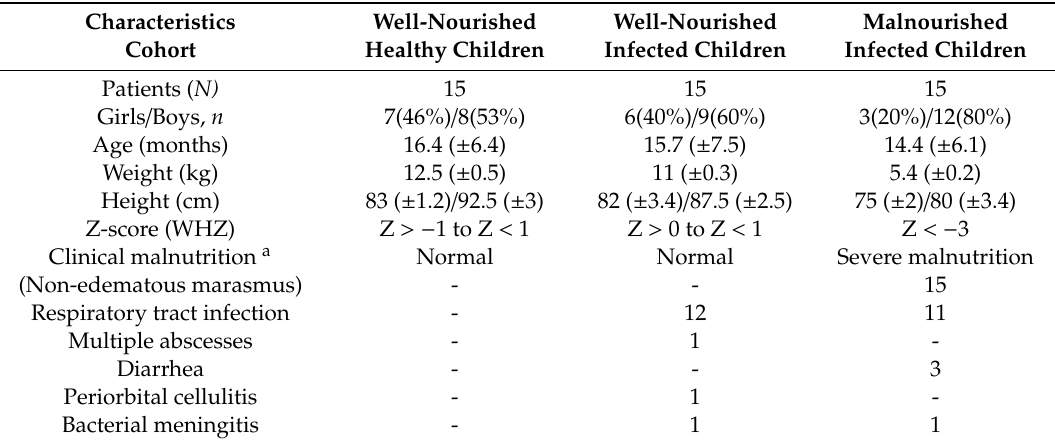
Table 1. Demographic characteristics of children enrolled in this